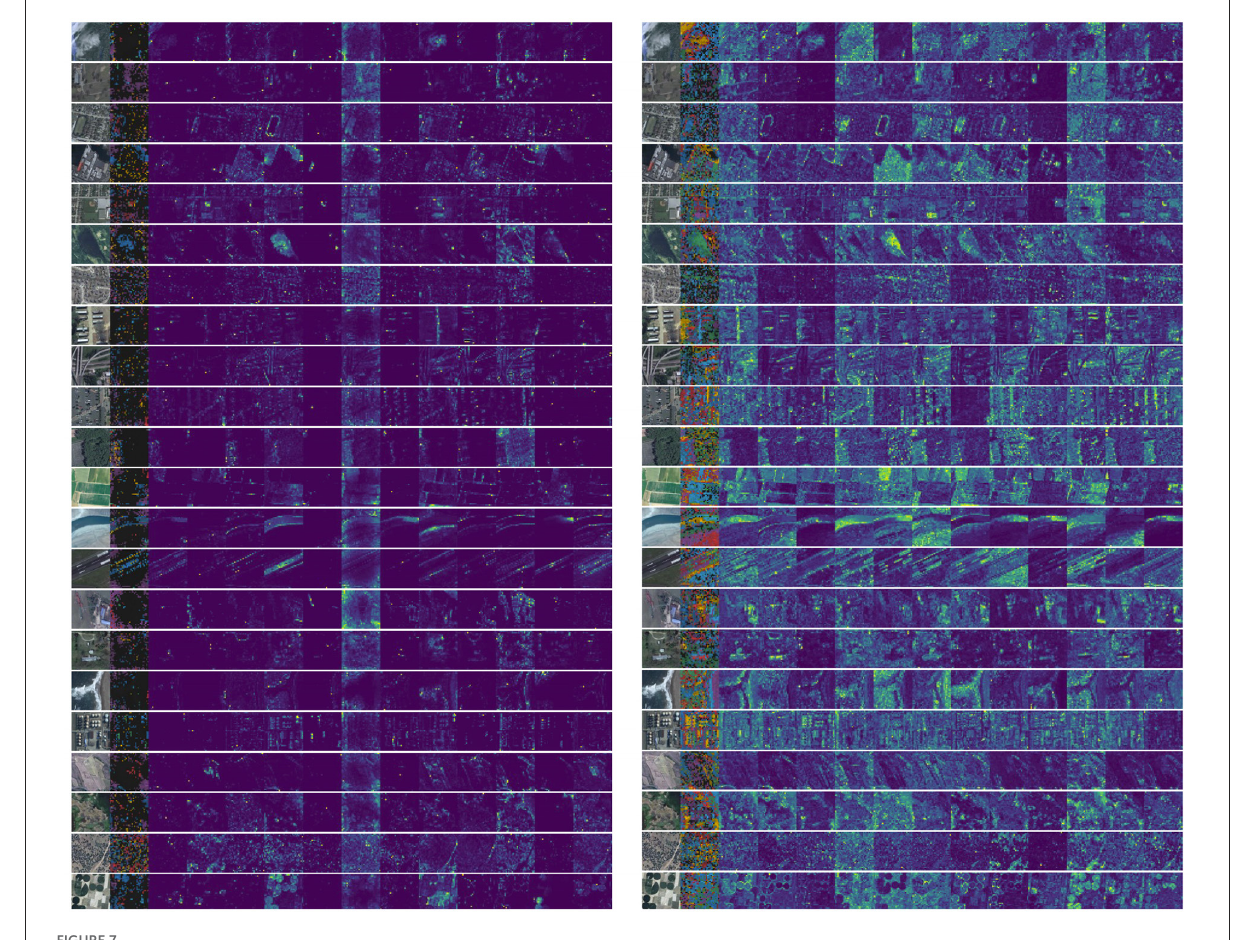
FIGURE7 Attention map visualization for GSC-MIM (left) and DINO (right)